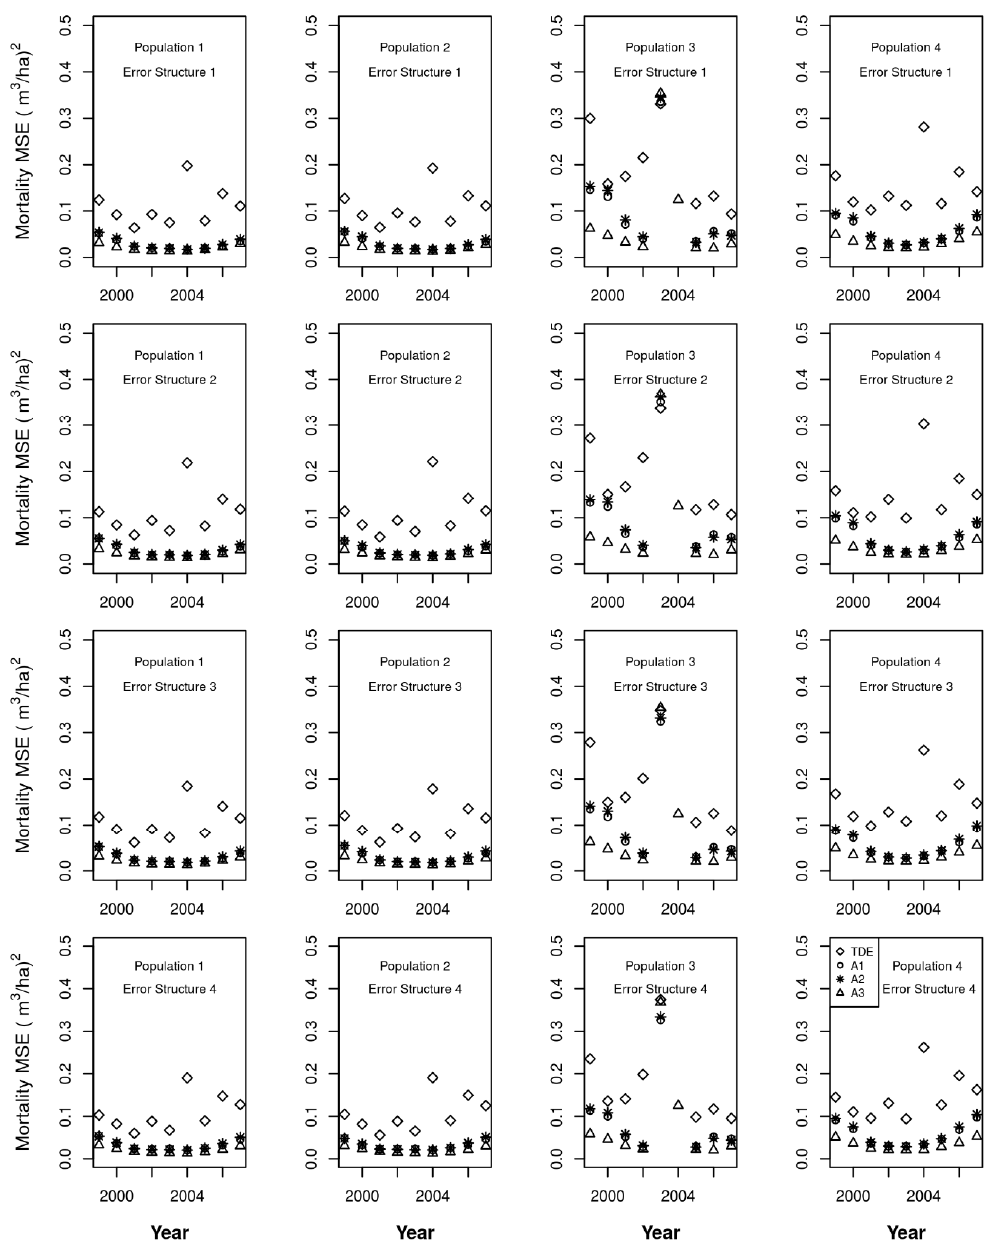
Figure 5. The mean squared errors ( MSE s) of the mortality estimators over 1000 iterations of 1000 samples for each population and sample error structure. (For clarity, the TDE, A1, and A2 estimators are not shown for population 3, year 2004, as their values were about 12 to 15 times higher than the value for A3.)